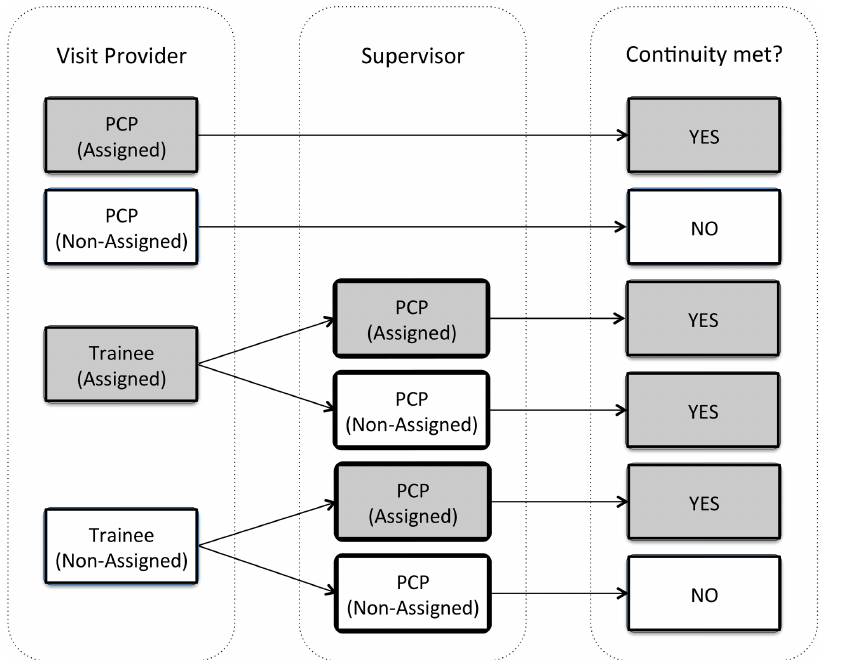
Figure 1. Potential Patient Visit Interactions with a Provider and/or Trainee and the Relationship with Continuity. PCP: primary care provider. Grey boxes indicate visits with continuity of care and white boxes indicate visits without continuity.